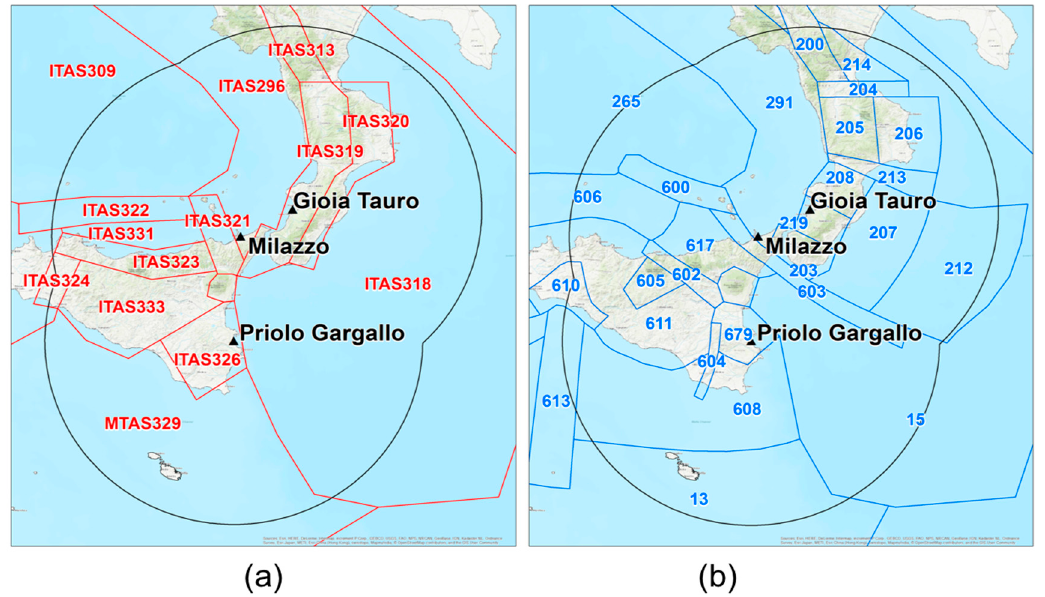
Figure 23. Seismogenic zones used in this study that follow within a buffer of 200 km around the three sites of interest: ( a ) SHARE, [70]; and ( b ) A1MPS16, [72]. Table 7. Seismic characterization of each SHARE zone [70]. a and b are the parameters of the Gutenberg–Richter distribution. M min and M max are the minimum and maximum moment magnitudes for PSHA. FM: Focal Mechanism; NF: Normal Faulting; RF: Reverse Faulting. h: Reference depth. ASC: Active Shallow Crust; SSC: Stable Shallow